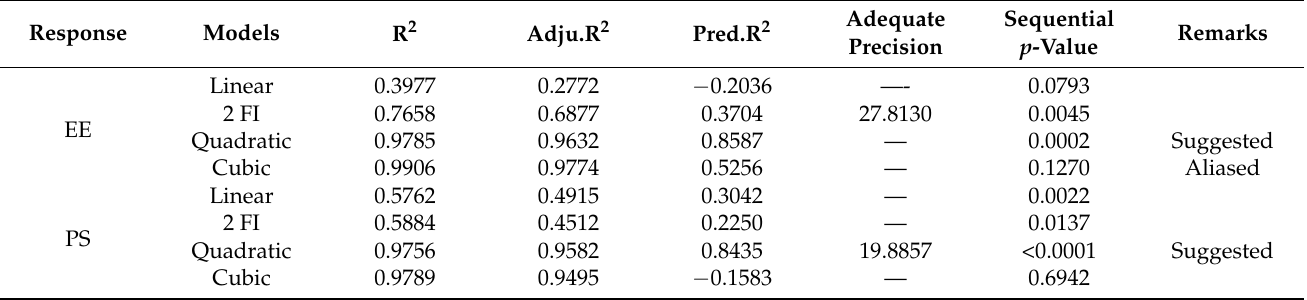
Table 3. Model statistical